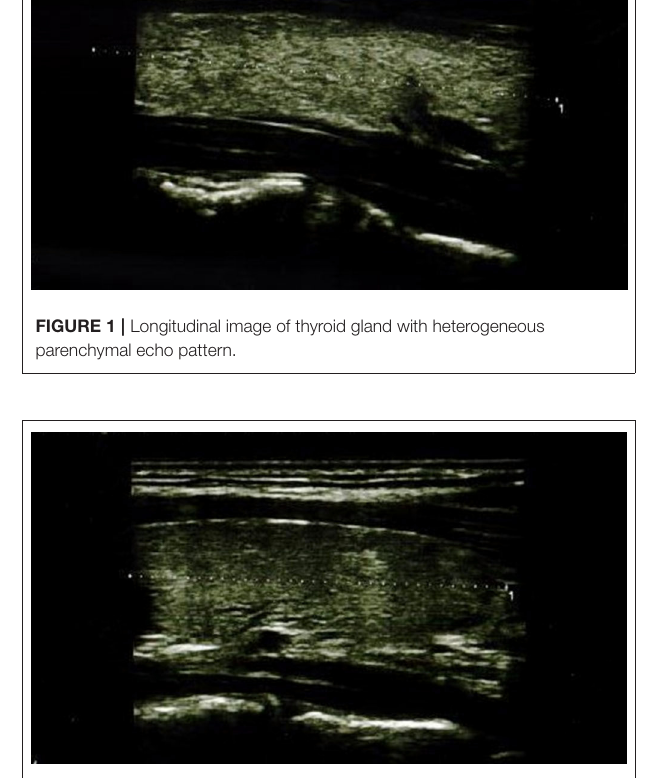
FIGURE 2 | Longitudinal image of thyroid gland with slightly decreased parenchymal echo pattern.